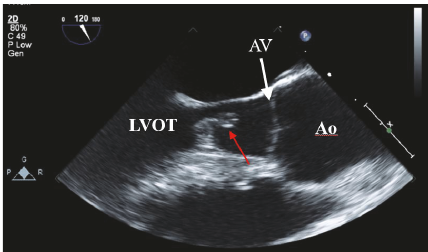
Figure 3: Transesophageal echocardiogram mid-esophageal posi- tion. The mass moves out of view during systole; red arrow indicates location of mass attachment to the left ventricular outflow tract. Ao = aorta and AV = aortic